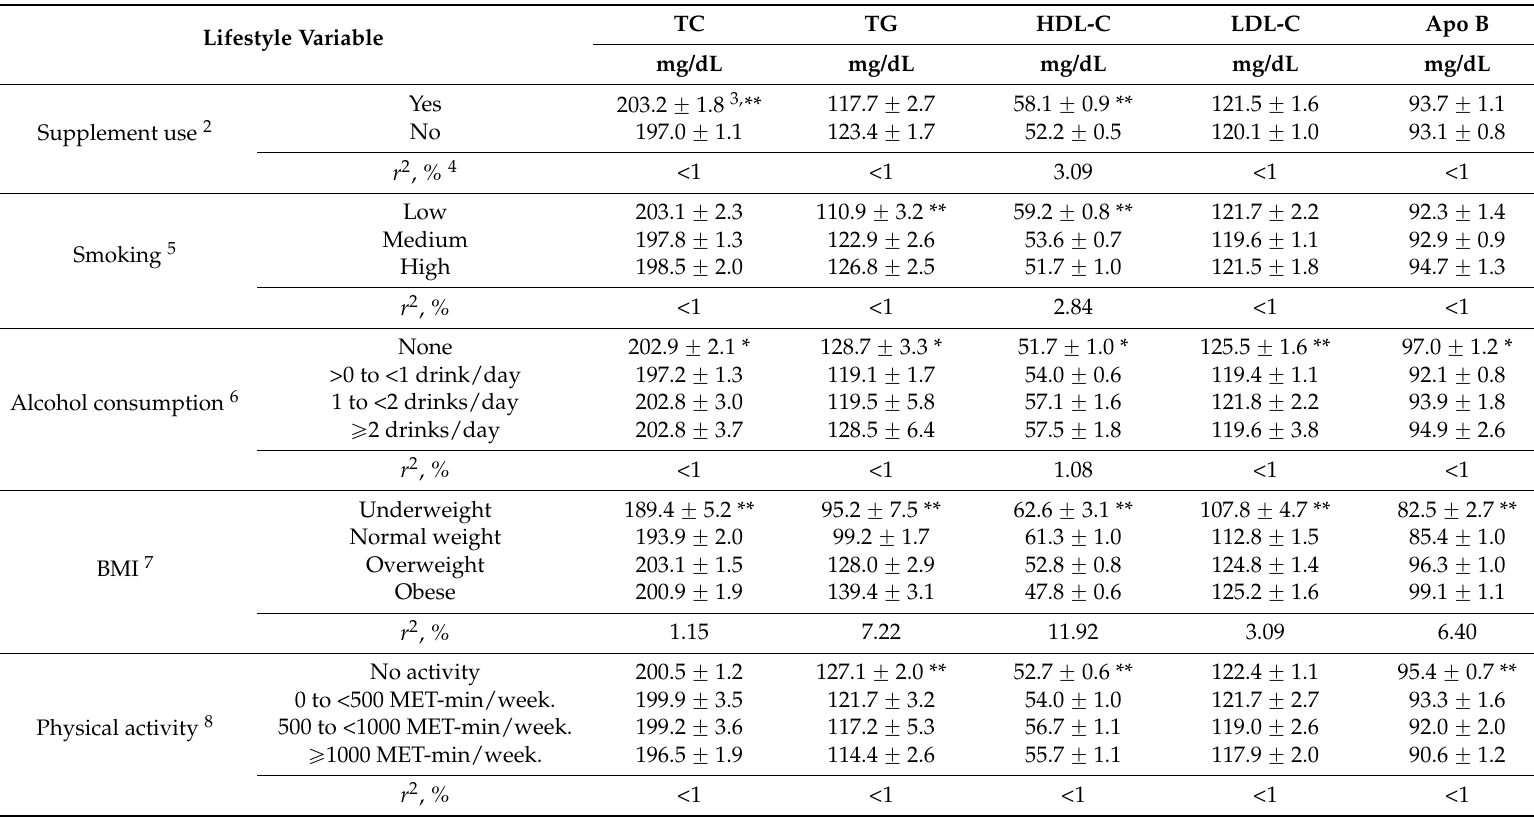
Table 2. Unadjusted serum lipid status biomarker levels by lifestyle variable categories for US adults, NHANES 2007–2012 1